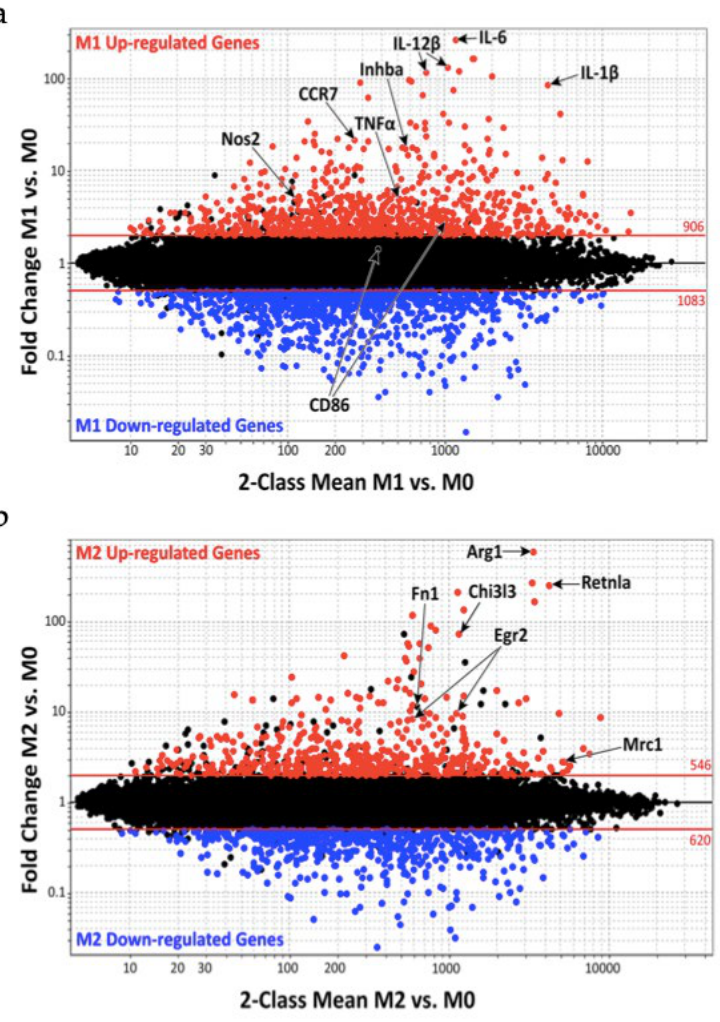
Figure 1. Macrophage gene expression during the classically activated M1 and alternatively acti- vated M2 phenotypes: ( a ) genes up and down regulation during M1 activation; ( b ) genes up and down regulation during M2 activation.